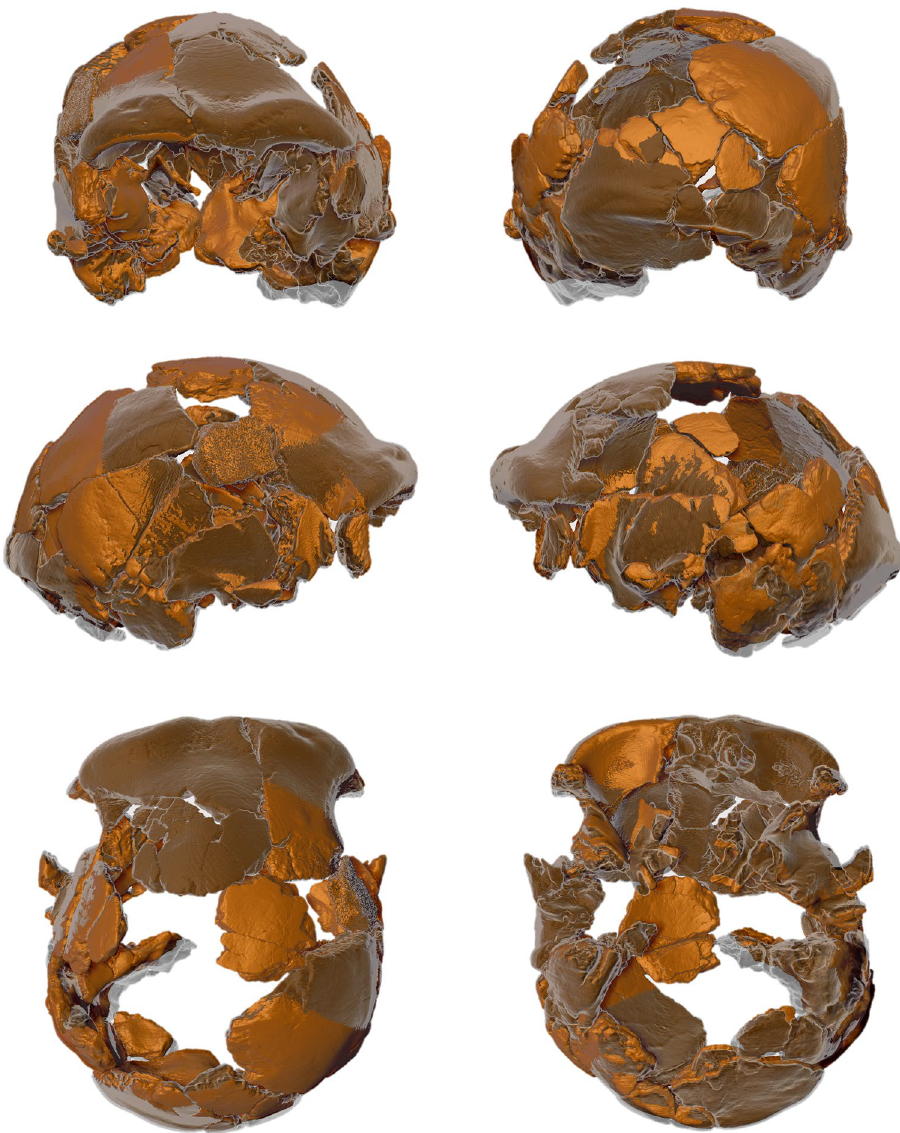
Figure 5. These six views show our digital restoration of the Ceprano calvarium superimposed on the last physical reconstruction. In this representation, transparent (light gray) anatomical parts correspond to previous positions of bony elements that moved to new positions (in light brown), contrasting with those that are unchanged (in dark